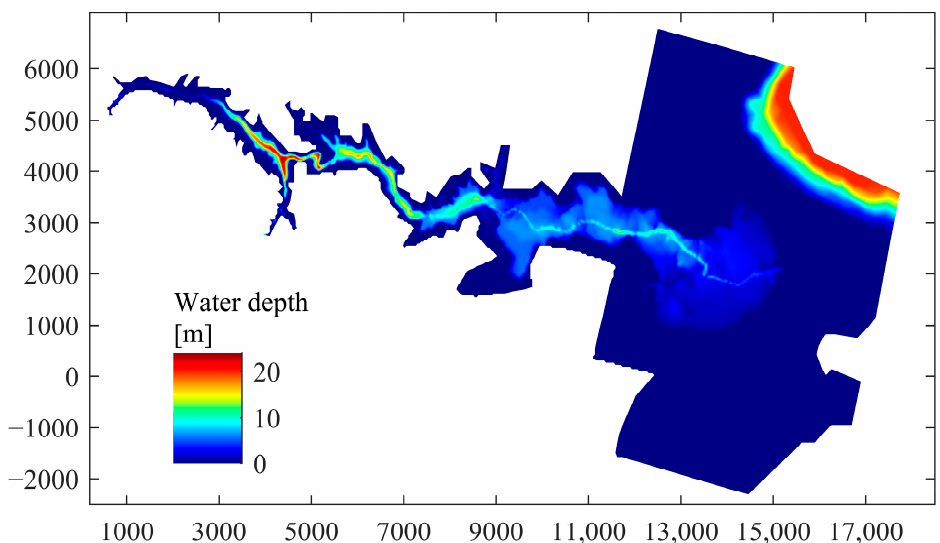
Figure 16. Malpasset dam break: numerical fl ood routing at t = 2000 s.